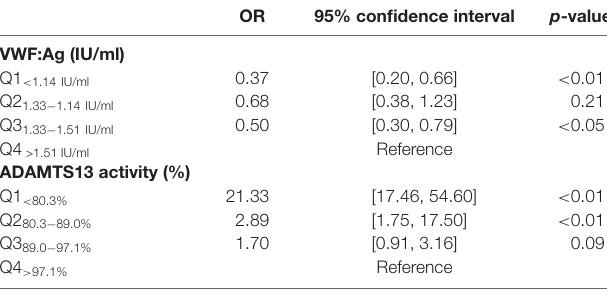
TABLE 5 | Multiple ordinal regression analysis of total CSVD score with